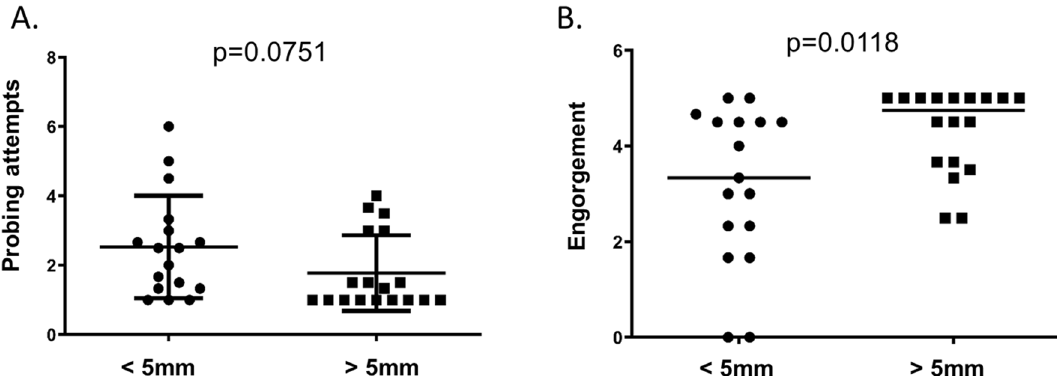
Figure 2. Mosquitoes feed better on hypersensitive subjects. Up to three mosquitoes probed the left forearms of non-sensitive (< 5 mm) and hypersensitive (> 5 mm) human subjects for five minutes. ( A ) The average number of probing attempts was quantified per human subject. ( B ) Mosquito engorgement was quantified on a 0–5 scale. Statistical significance between groups was determined after testing for normal distribution using the